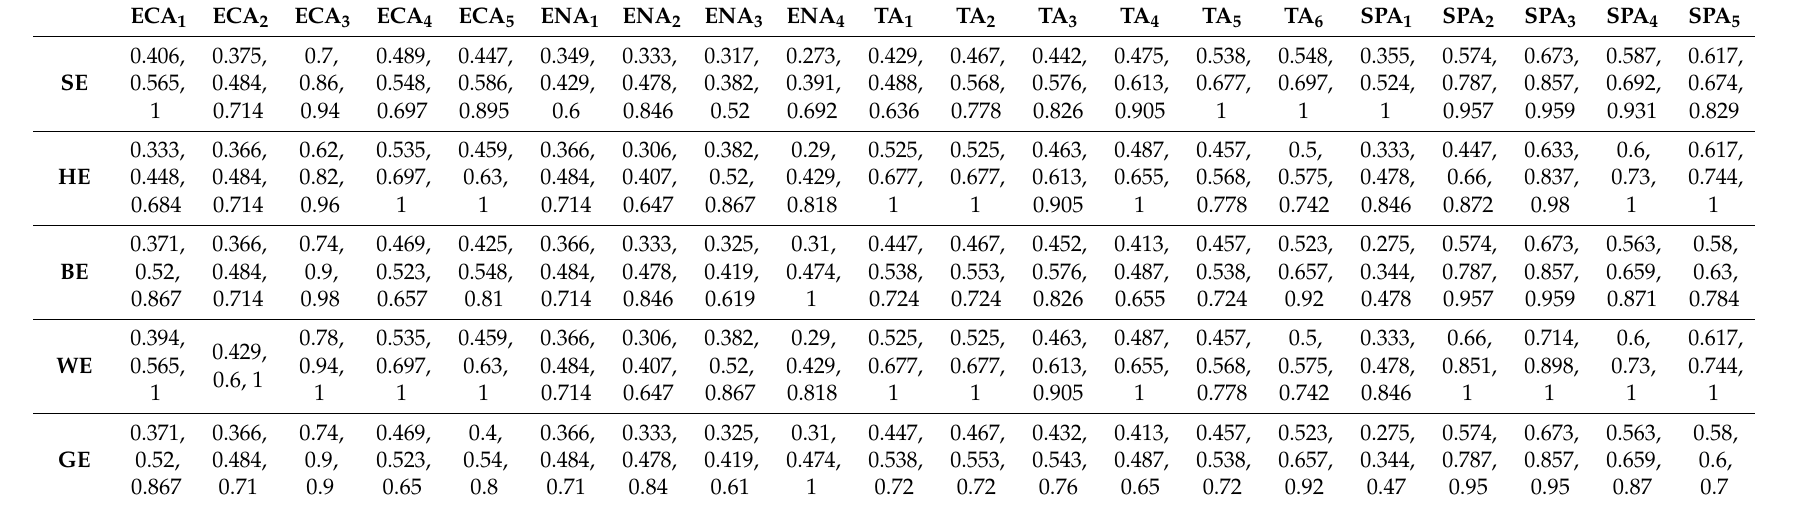
Table A9. Normalized decision